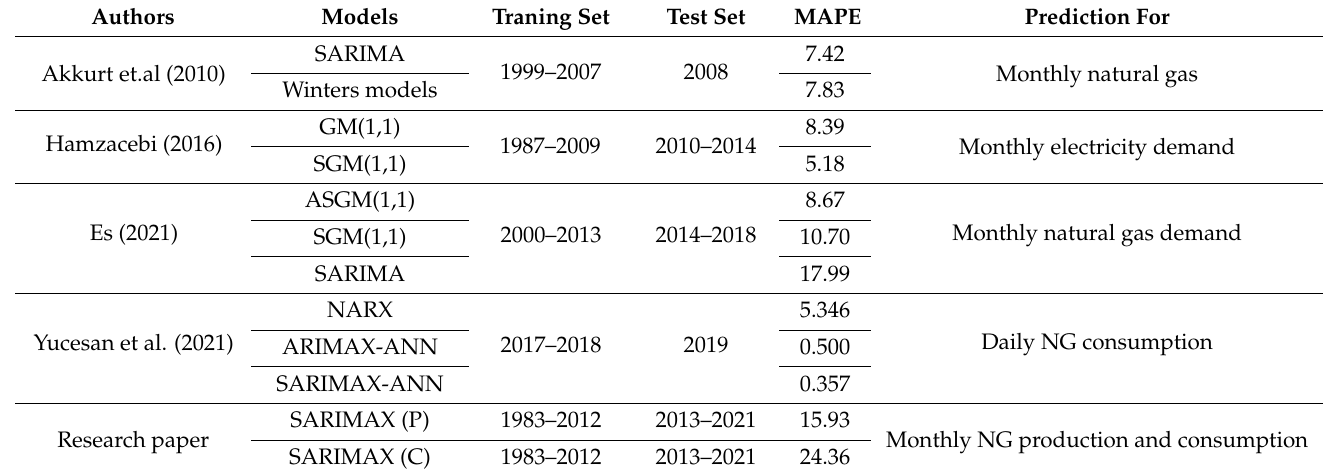
Table 7. The comparison results for SARIMAX and similarly other papers findings.